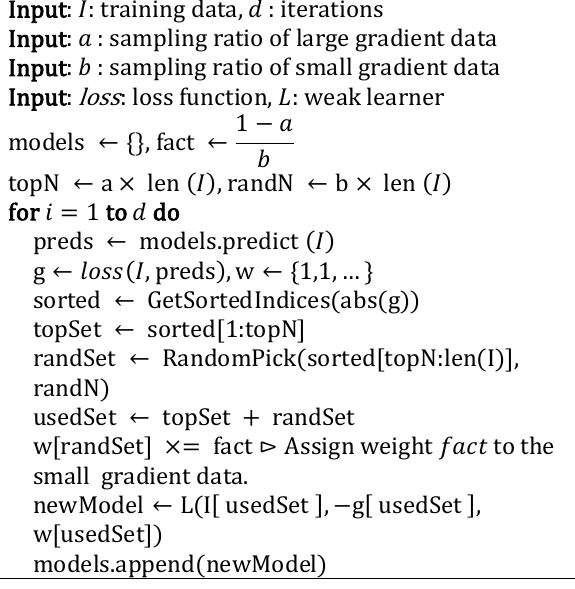
Figure 2. Leaf-wise tree